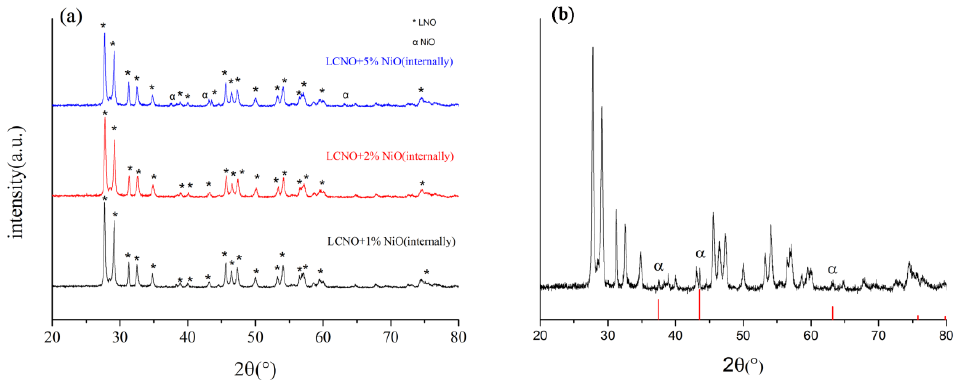
Figure 4. ( a ) XRD patterns for 1, 2 and 5 wt.% NiO-doped LCNO powders by an internal addition method fired at 1100 °C; ( b ) labels of excessive peaks from 5 wt.% doping XRD patterns.